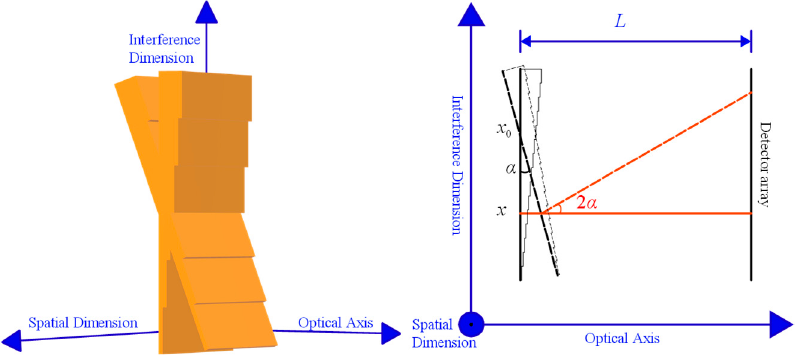
Figure 3. Tilt error structure.